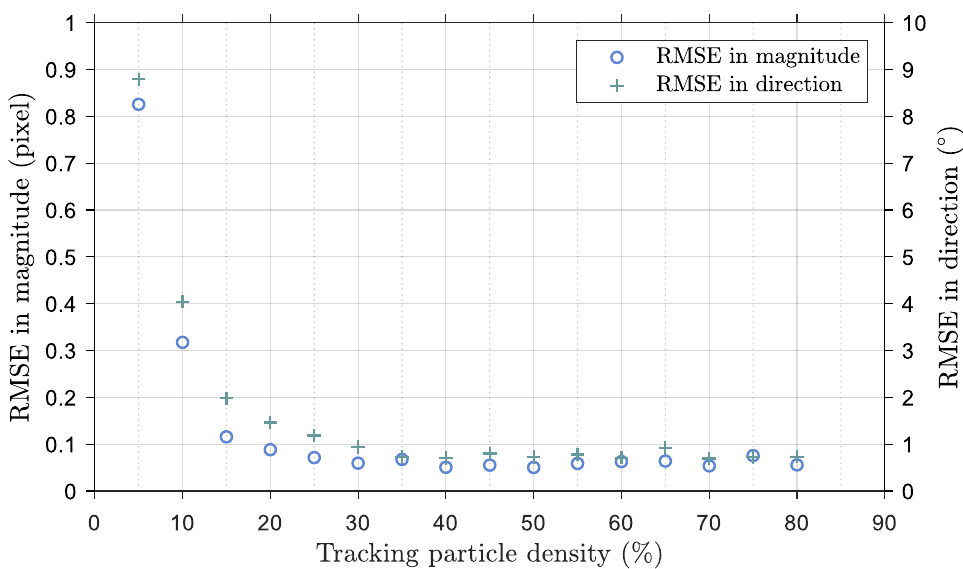
Figure 9. RMSEs in magnitude and direction against different tracking particle densities in a synthetic stratified crossflow.